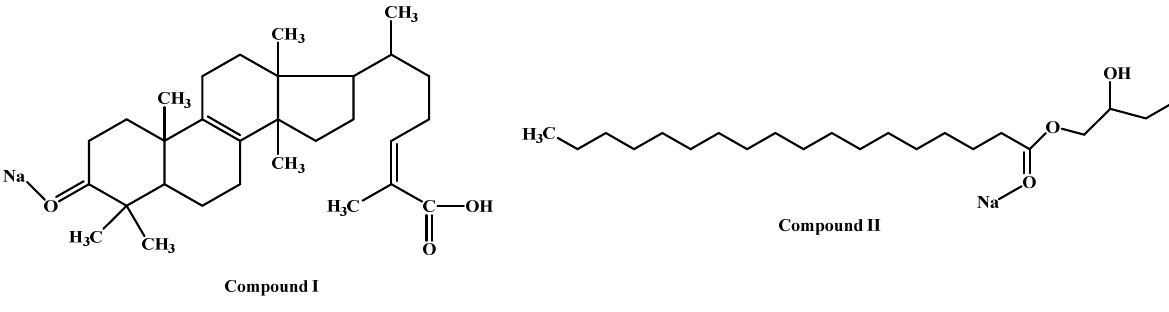
Figure 3. The structures of the proposed compounds based on the data from the ESI-MS analysis.